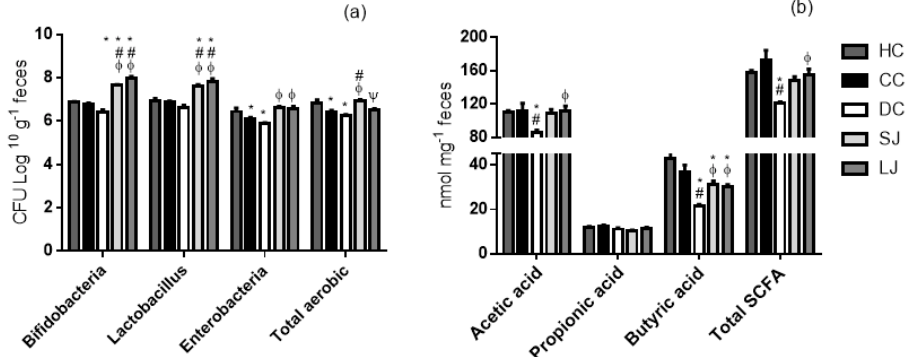
Figure 2. Microbiota and short-chain fatty acid (SCFA) production in cecal content. ( a ) Cecal